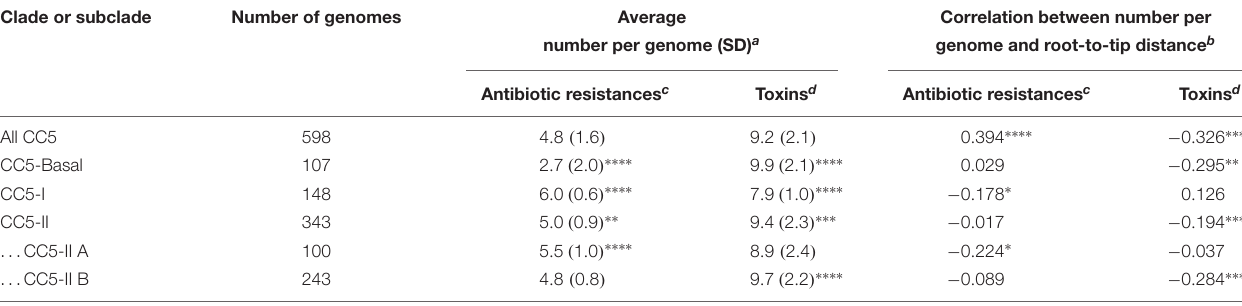
TABLE 3 | Comparisons of antibiotic resistance and toxin traits in CC5 clades. Clade or subclade Number of genomes